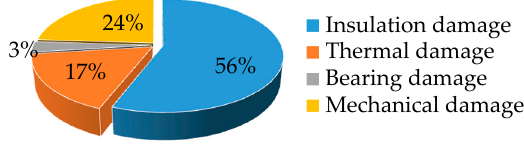
Figure 1. Failure statistics based on data presented in [1].